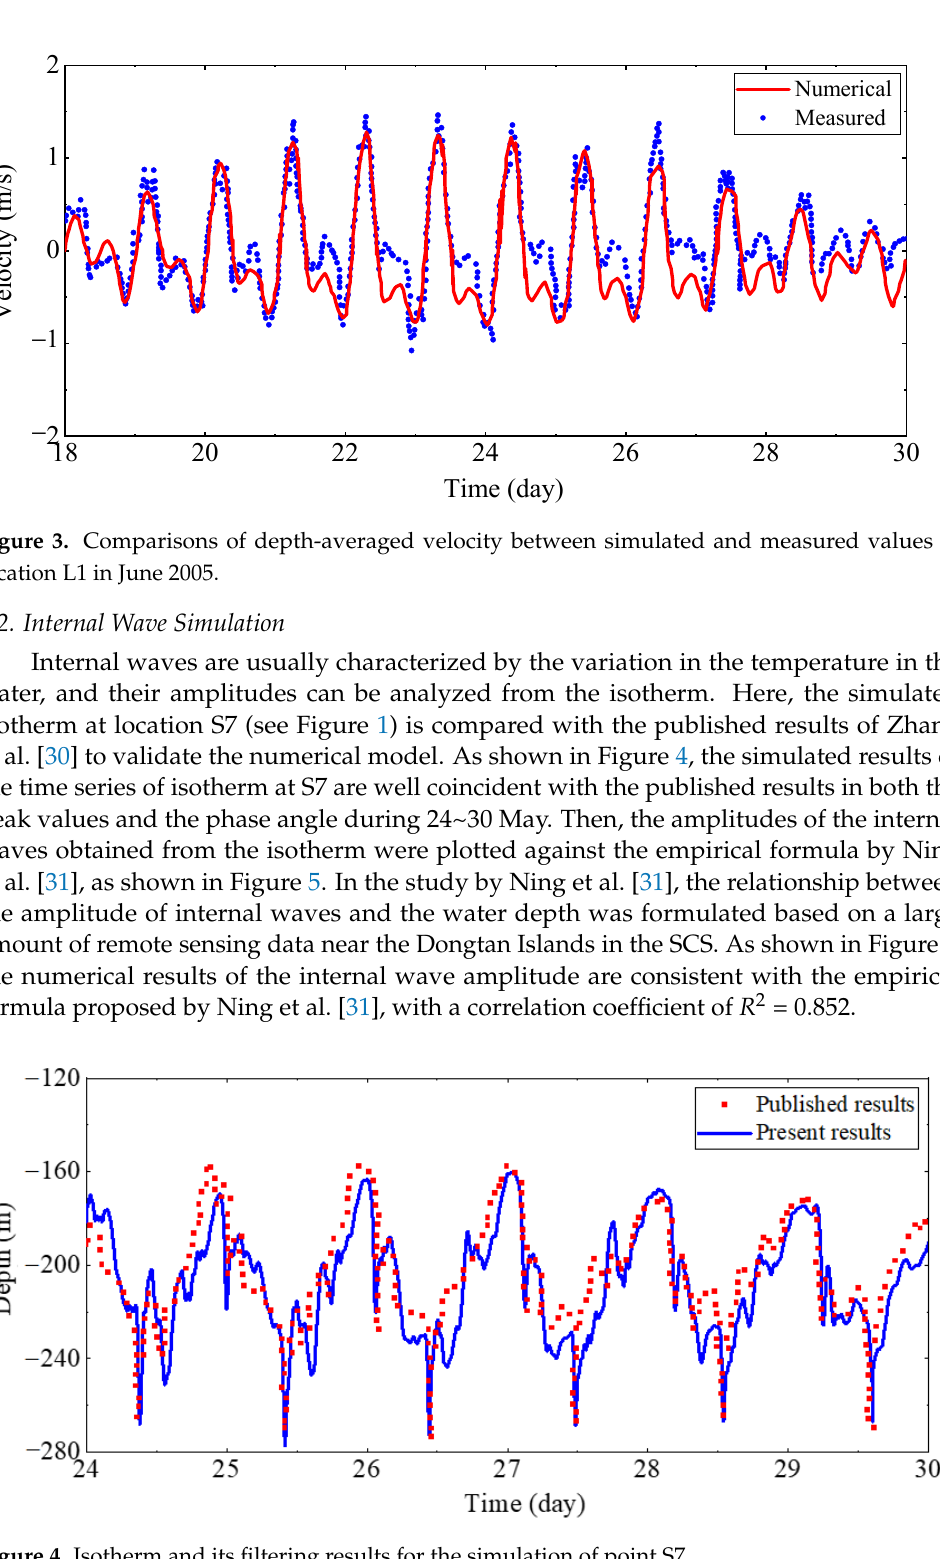
Empirical Numerical Figure 5. Relationship between the amplitude and the water depth. The current velocity near the bottom induced by the internal waves at location A1 during 24~30 May was further output and compared with the measured data from Zhang et al. [3], as shown in Figure 6. The simulation results are generally in good agreement with the measured results from the peak value and variation period of the velocities, although there is a slight phase shift between the two sets of data, which may have been caused by the large spatial resolution of the seabed topography (~5 km) at the assessed area. Considering that the main purpose of the present study was to investigate the di- rection and strength of sediment transport on the continental slope induced by internal waves, a slight phase shift in the velocities has little effect on the direction of bottom currents and the resultant sediment transport.